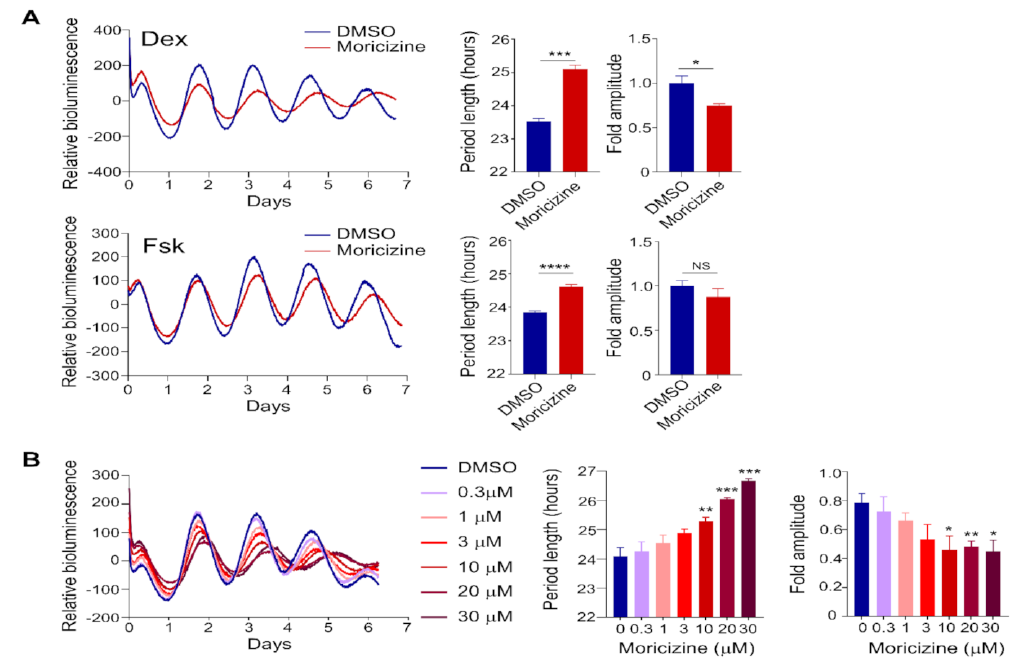
Figure 1. Moricizine lengthens the circadian period of mouse Per2::LucSV reporter fibroblast cells. ( A ) Representative PER2::LUC bioluminescence recording of Per2::LucSV fibroblast cells. Cells were synchronized by Dex (200 nM, n = 3) or Fsk (1 µ M, n = 8). Average circadian period lengths and amplitudes show a period-lengthening effect with moricizine (10 µ M), compared to controls. ( B ) Representative PER2::LUC bioluminescence recording, average circadian period lengths and amplitudes of Per2::LucSV fibroblast cells treated with increasing concentrations of moricizine ( n = 4 for each concentration). Data are presented as mean ± SEM. T -test shows significant statistical differences between DMSO and moricizine. (*, p < 0.05; **, p < 0.01; ***, p < 0.001; ****, p < 0.0001).